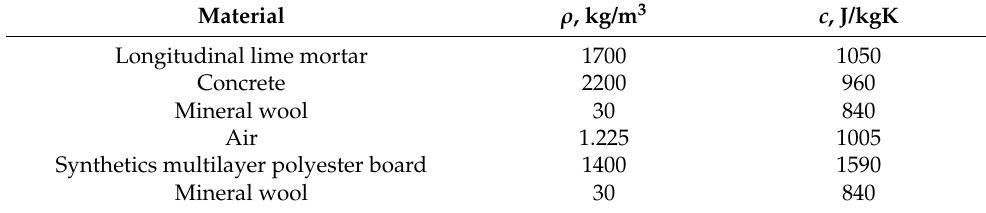
Table 1. Thermo-physical properties of materials used for the external wall of the ventilated façade.